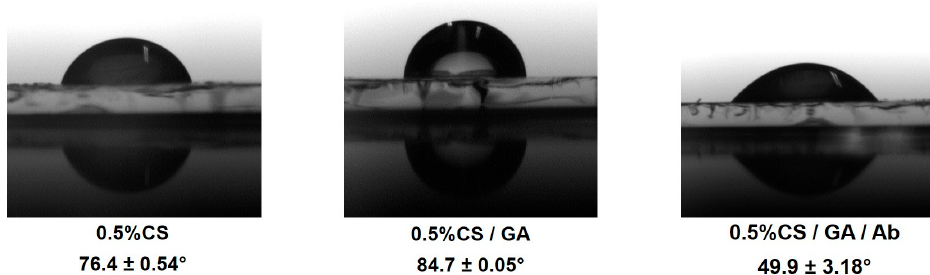
Figure 2. Measurements of contact angles of a water droplet on a 0.5% chitosan (CS) layer, crossed linked with glutaraldehyde (GA), and after immobilization of anti-OV6 antibodies.